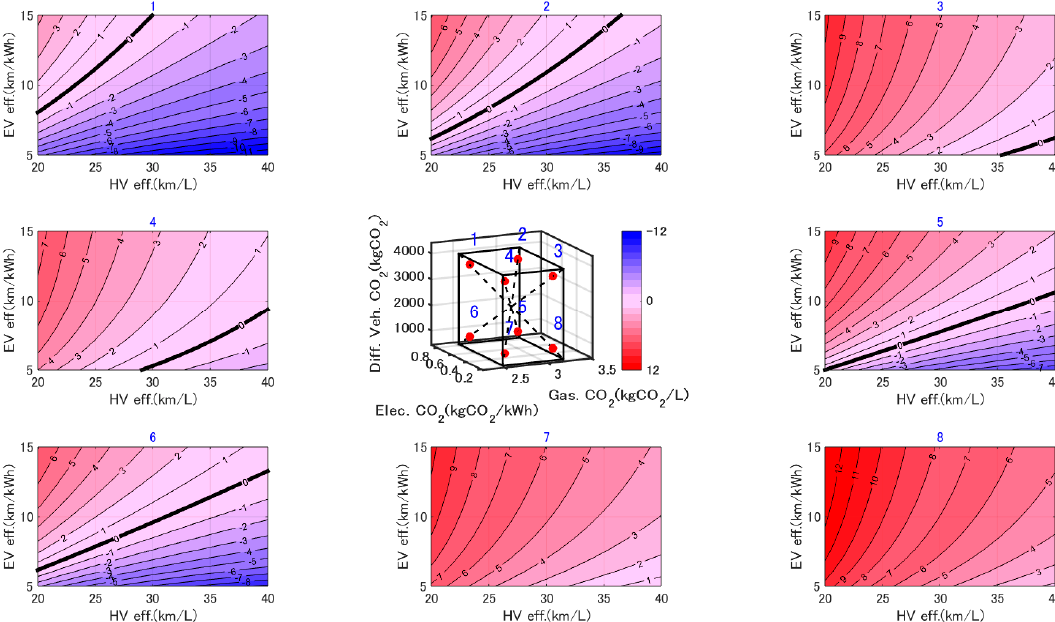
Figure 8. Five-dimensional diagram of LCCO 2 comparison emphasizing vehicle efficiency with difference of vehicle CO 2 emissions during production ∆ D set to 4000 kg.